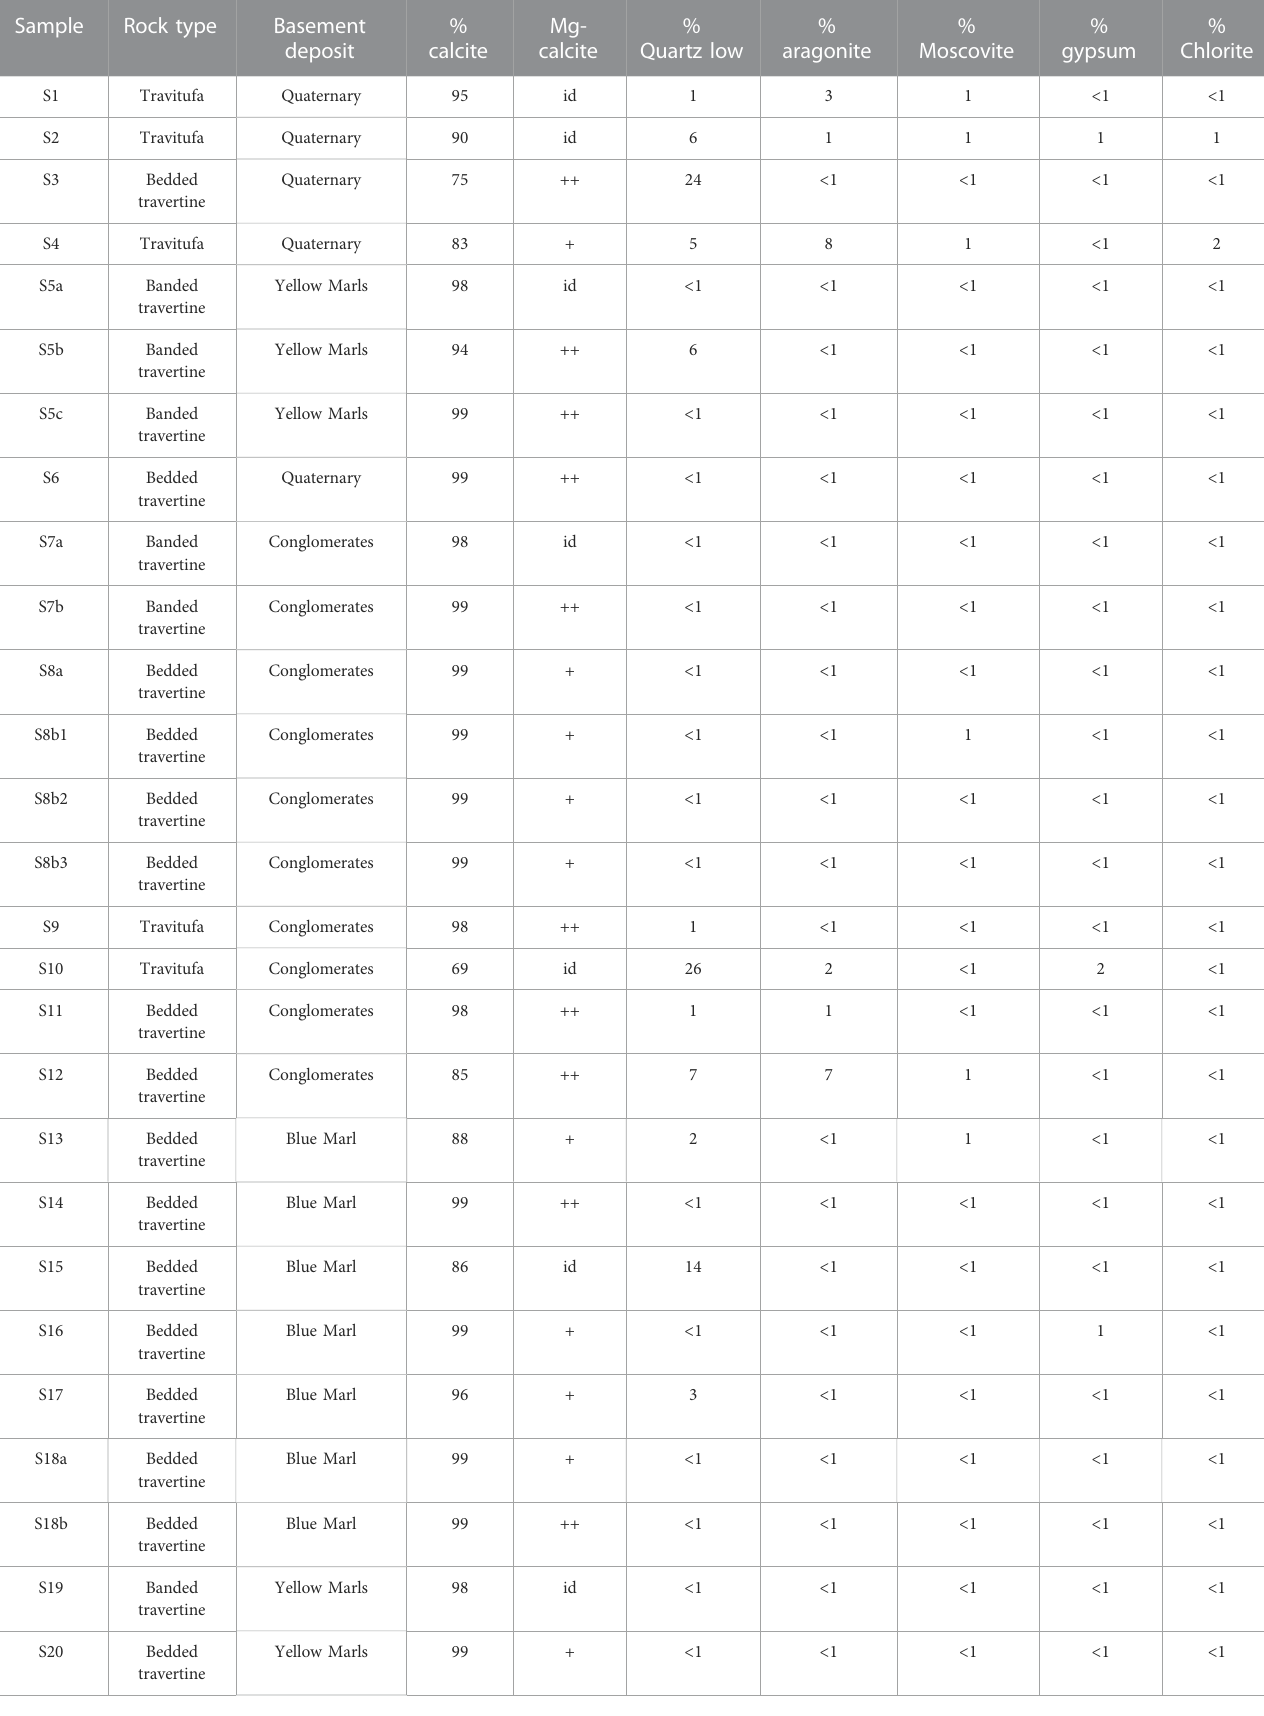
TABLE 3 Mineralogical compositions of the Carraclaca site samples based on XRD analyses. ++: > 10%. +: 5% – 10%. Id: identi fi ed.